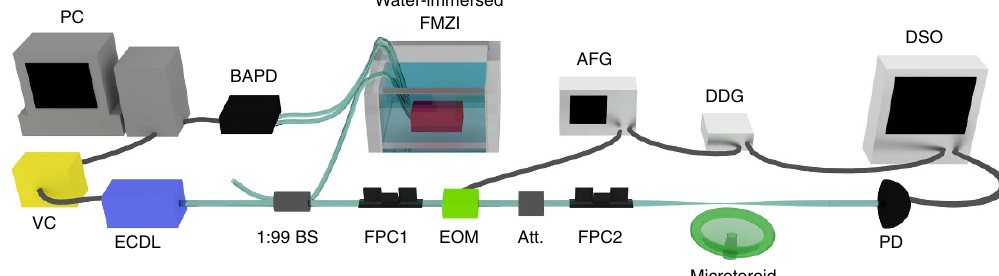
Figure 4 | Schematics of the experimental setup. The light pulses are prepared by modulating the light from a tunable ECDL using an EOM driven by an arbitrary function generator (AFG). The prepared pulses are coupled in and out of the silica microtoroid resonator using a tapered optical fibre. The transmitted light is detected by a PD connected to a digital sampling oscilloscope (DSO). The DSO and the EOM are synchronized with the digital delay generator (DDG). The coupling is adjusted by controlling the distance between the tapered fibre and microtoroid. The required frequency detuning for the experiments is achieved with the help of a FMZI. For this purpose, a portion ( B 1%) of the ECDL output is tapped out with a 1:99 beamsplitter (BS) and sent to the input port of the FMZI. The output of the FMZI is detected by a BAPD, which produces an error signal when the frequency of the ECDL deviates from the pre-determined value. The FMZI is immersed in a water environment to reduce vibrations and to block any ambient air changes. The generated error signal is processed and a suitable control signal is generated using a voltage controller (VC). The control signal is applied to the piezoelectric transducer of the ECDL to control the frequency of the light emitted by the ECDL. The polarization of the light before and after the EOM is adjusted using fibre-polarization controllers (FPC1 and FPC2). An attenuator (Att.) is used to attenuate the light before it is coupled to the resonator to prevent thermal and nonlinear